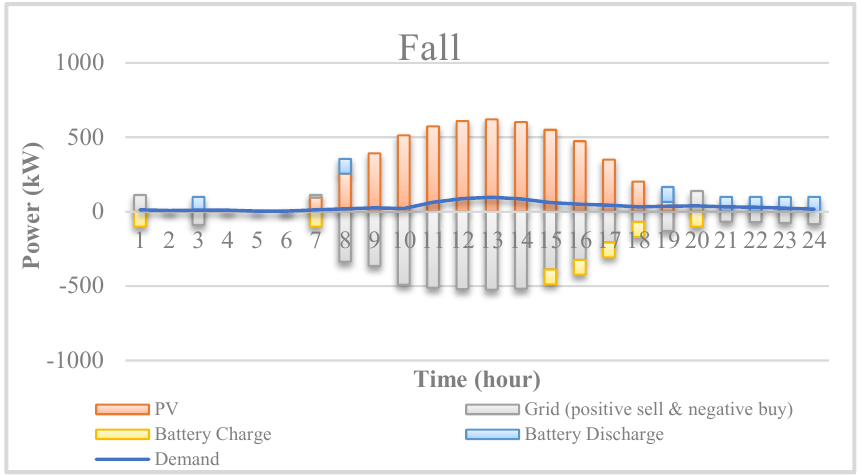
Figure 12. The bidding power of the VPP in fall.